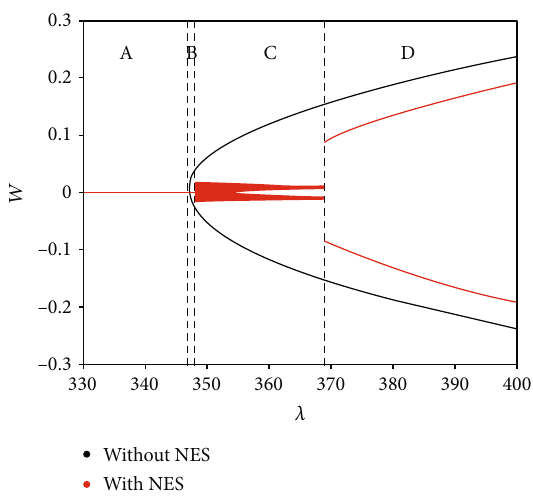
Figure 3: Bifurcation diagram of the panel fl utter response with and without an